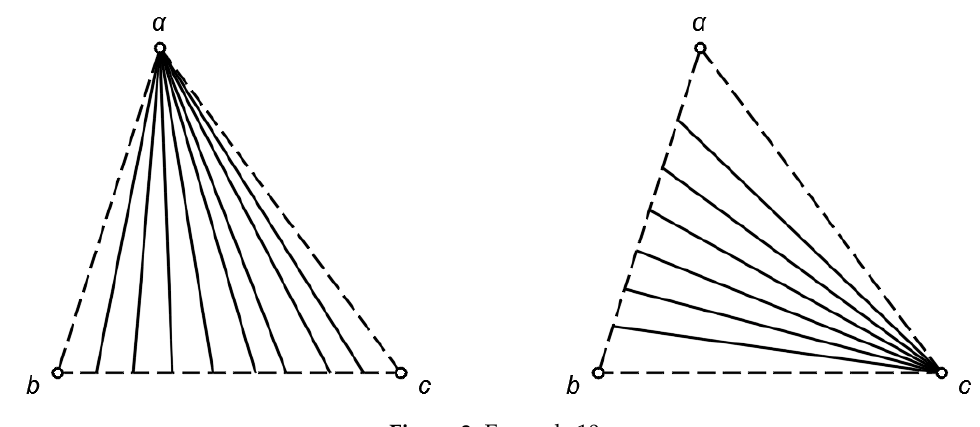
Figure 3. Example 10.